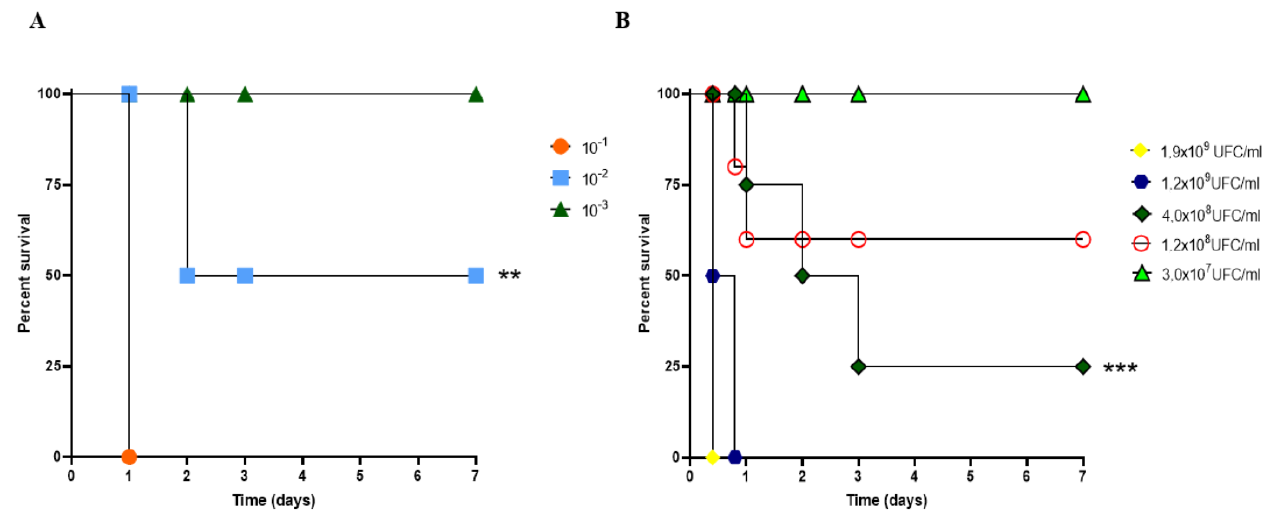
Figure 1. Determination of the lethal dose of A. baumannii in CY-untreated mice. ( A ) The survival rate of mice subjected to bacterial challenge using serial dilution ranged from 10 − 1 to 10 − 3 . (**) p < 0.01). ( B ) Survival curve of mice submitted to bacterial challenge using colony-forming unit (CFU/mL